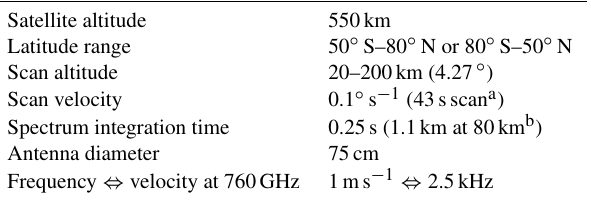
Table 2. SMILES2 observation characteristics. Satellite